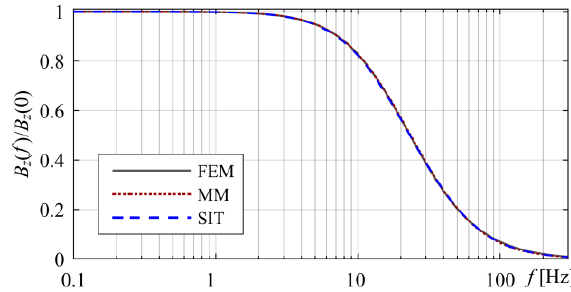
Fig. 6. Frequency characteristics of the MT3 model.